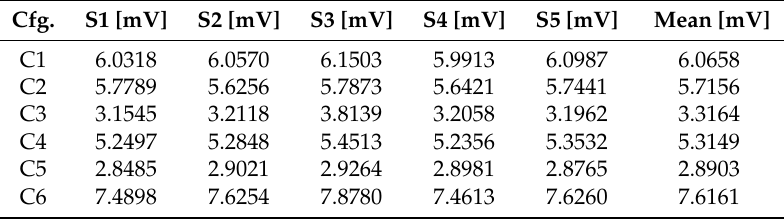
Table 4. Measured energy consumption for five sensor devices of the same type. Cfg.